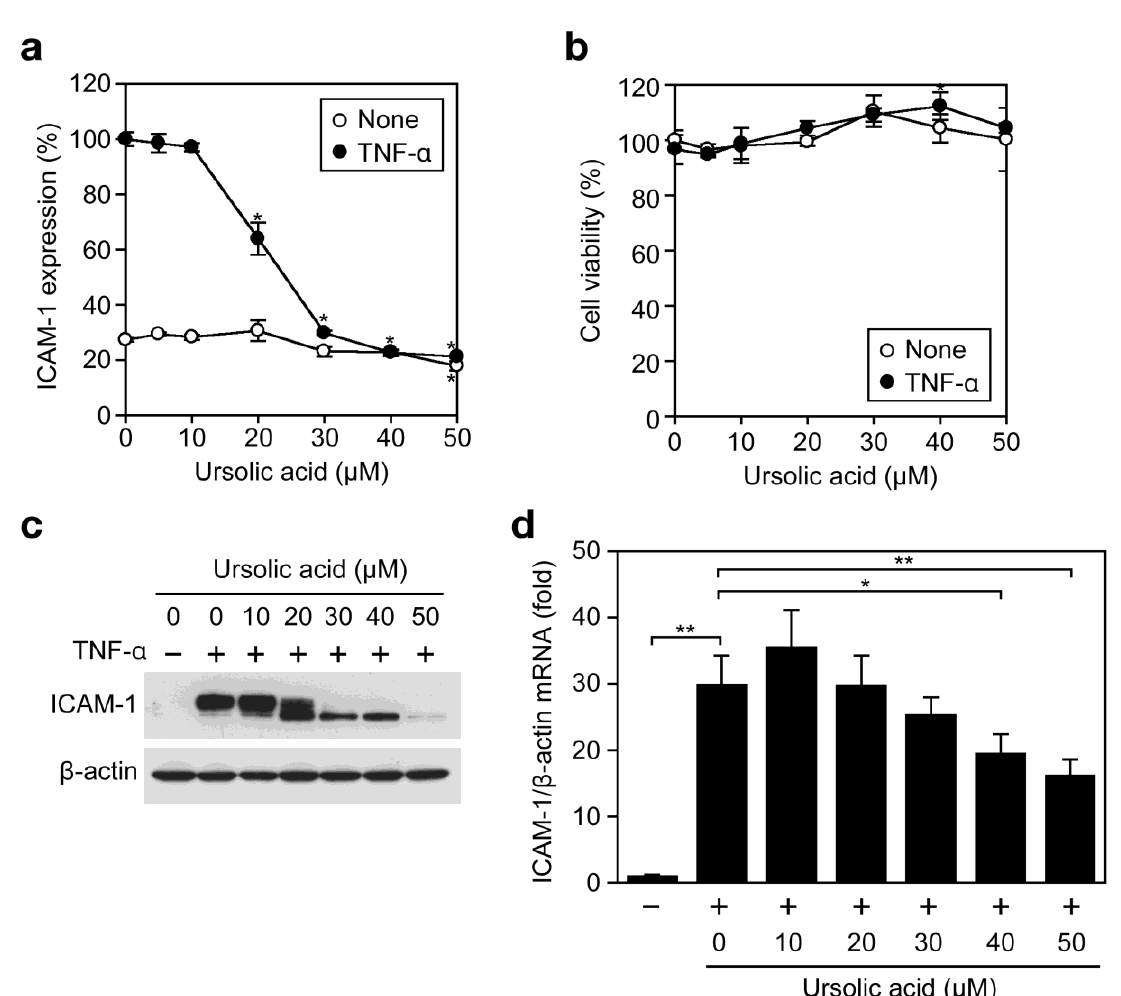
Figure 2. Ursolic acid inhibits TNF-α-induced ICAM-1 expression. ( a ) A549 cells were preincubated with various concentrations of ursolic acid for 1 h and then incubated with (filled circles) or without (open circles) TNF-α (2.5 ng/mL) for 6 h in the presence of ursolic acid. ICAM-1 expression (%) was measured by the Cell ELISA assay. Data points represent means ± SD (n = 3). * P < 0.01, compared with control; ( b ) A549 cells were incubated with various concentrations of ursolic acid for 1 h and then incubated with (filled circles) or without (open circles) TNF-α (2.5 ng/mL) for 6 h in the presence of ursolic acid. Cell viability (%) was measured by the MTT assay. Data points represent means ± SD (n = 3). * P < 0.05, compared with control; ( c ) A549 cells were preincubated with various concentrations of ursolic acid for 1 h and then incubated with (+) or without (–) TNF-α (2.5 ng/mL) for 6 h. Protein expression of ICAM-1 was analyzed by Western blotting; ( d ) A549 cells were pretreated with indicated concentrations of ursolic acid for 1 h and then incubated with (+) or without (–) TNF-α (2.5 ng/mL) for 6 h in the presence of ursolic acid. ICAM-1 mRNA expression was measured by quantitative RT-PCR. The ratio of ICAM-1 mRNA relative to -actin mRNA is shown as means ± SD (n = 3). * P < 0.05 and ** P < 0.01, compared with